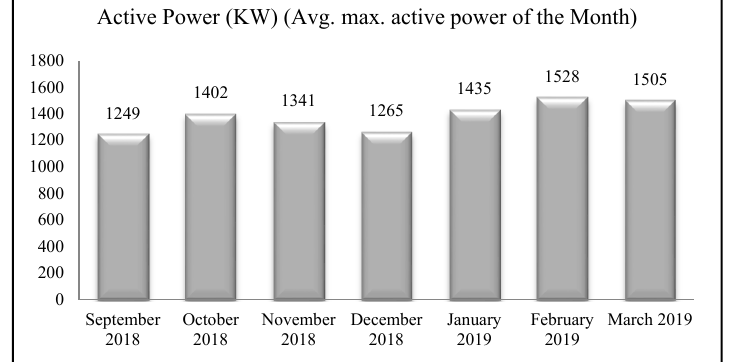
Figure 4. Hourly maximum active power averaged over the month.